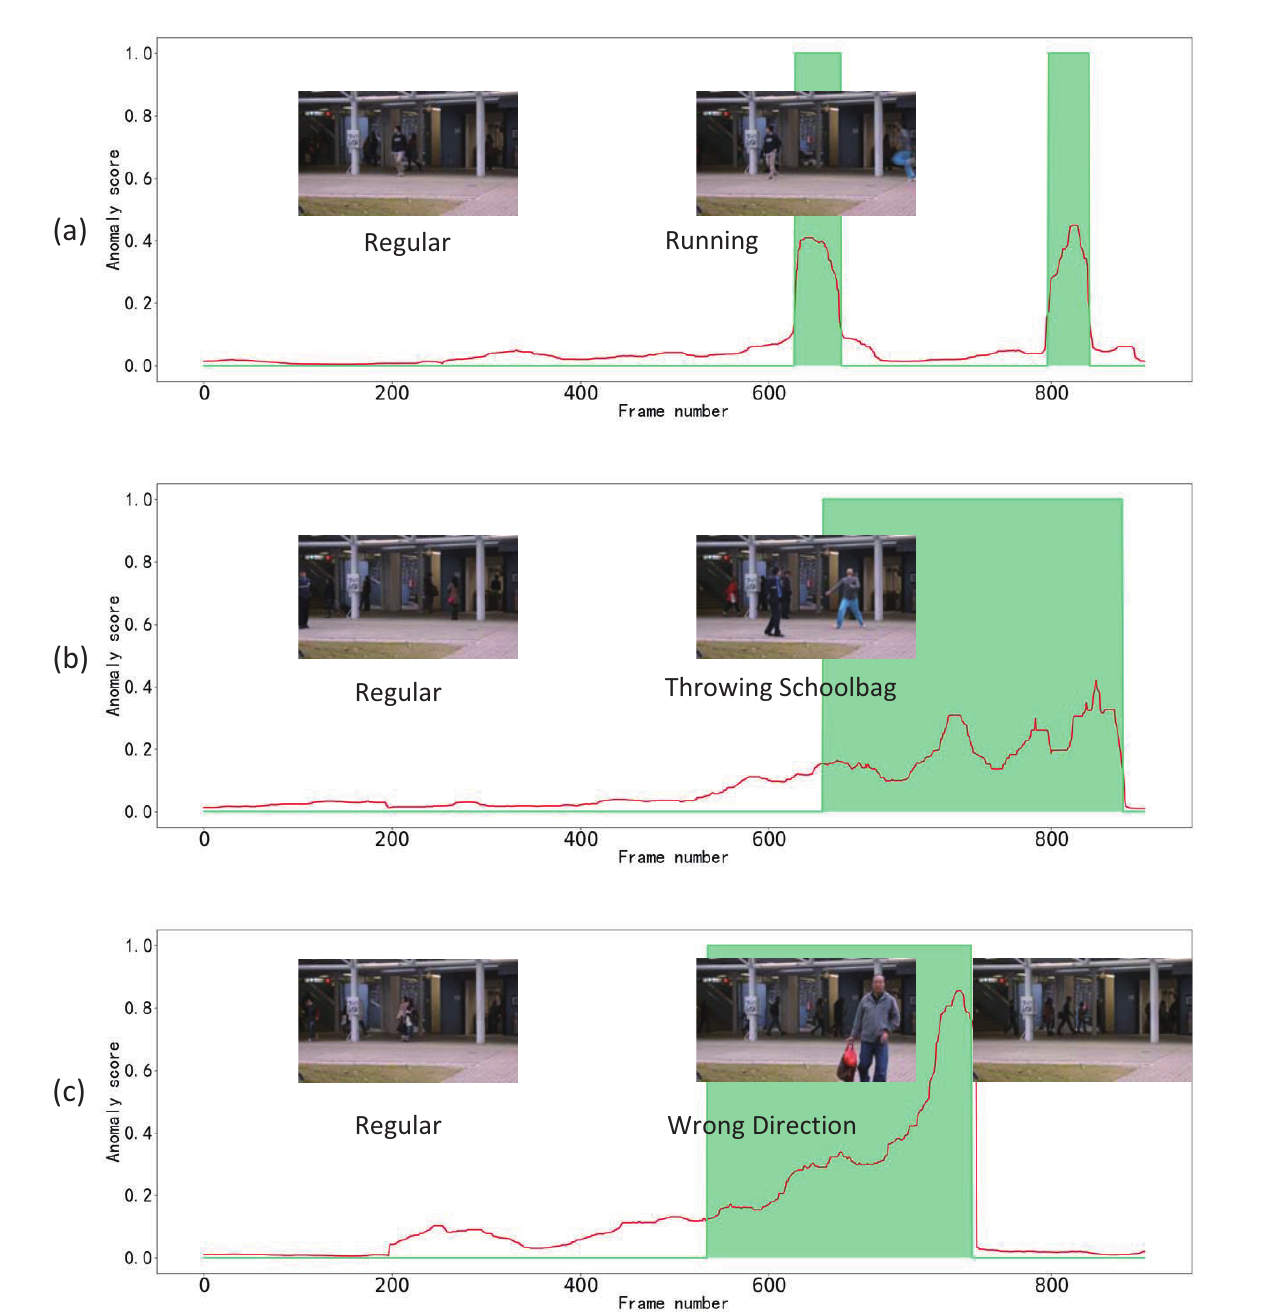
Figure 4. Frame-level anomaly-detection scores (between 0 and 1) provided by our FST-LSTM framework based on the late fusion strategy, for test in the Avenue dataset. The green lines and green zone represent the ground truth abnormal events. The red lines represent our scores. ( a ) Test video 4 in the Avenue dataset. ( b ) Test video 5 in the Avenue dataset. ( c ) Test video 6 in the Avenue